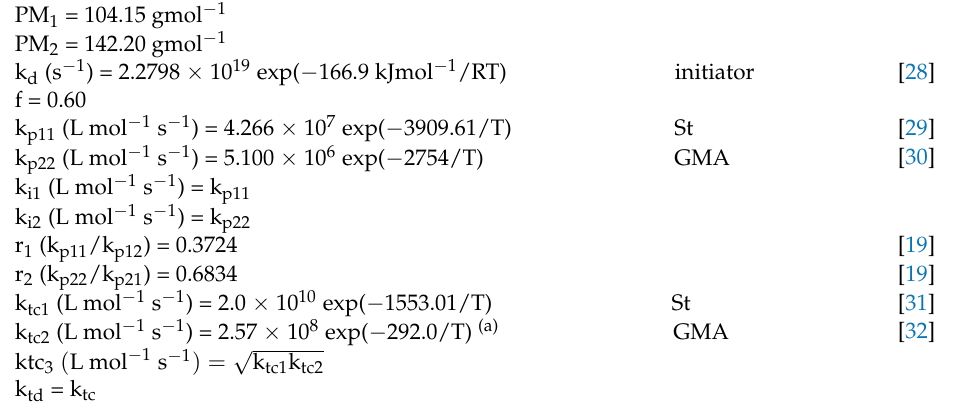
Table 5. Kinetic constants for RAFT copolymerization of St (1)-GMA